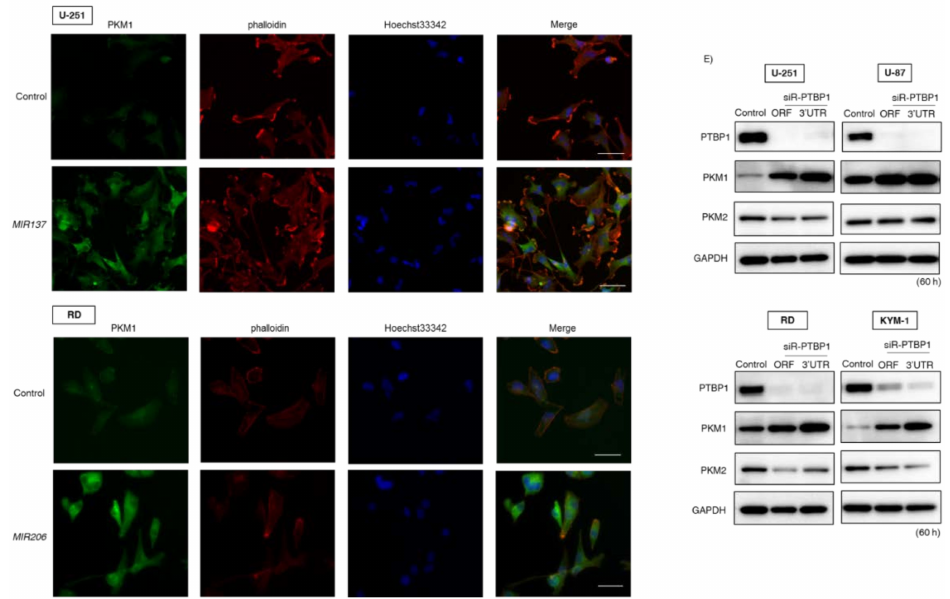
Figure 2. MIR137 and 206 regulated PKM isoform expression through the direct targeting of PTBP1 mRNA. ( A ) Protein expression levels of PTBP1 , PKM1 , and PKM2 at 60 h after the transfection with MIR137 or 206 . Human glioblastoma (GBM) cell lines (U-251 and U-87) were transfected with brain-specific MIR137 (20 nM). Also, rhabdomyosarcoma (RMS) cell lines (RD and KYM-1) were transfected with muscle-specific MIR206 (20 nM); ( B ) Luciferase activities after co-transfection with control or MIR137 or 206 and wild-type or mutant-type pMIR vectors having the predicted MIR137 or 206 binding site in the 3 (cid:48) UTR of PTBP1 . The upper panel shows the region of the 3 (cid:48) UTR of human PTBP1 mRNA complementary to the mature MIR137 or 206 . The box indicates the predicted binding sites for MIR137 or 206 . The left panel is the case of MIR137 transfected with U-251 cells. The right panel is the case of MIR206 transfected with RD cells. Effects were assessed at 24 h after the transfection (20 nM); ( C ) Protein expression levels of PTBP1 in U-251 and RD cells after combined treatment with antago MIR137 / MIR137 or antago MIR206 / MIR206 . Control lane: treatment with control miRNA (20 nM). MIR137 or 206 lane: treatment with MIR137 or 206 (20 nM). Inhibitor lane: treatment with MIR137 or 206 (10 nM) + antago MIR137 or 206 (10 nM). Effects were assessed at 60 h after the transfection; ( D ) Immunofluorescence of PKM1 at 60 h after transfection of U-251 cells with MIR137 or transfection of RD cells with MIR206 . Upper panels, treatment with control miRNA (20 nM); Lower panels, treatment with MIR137 or 206 (20 nM). PKM1 is dyed green; cell membrane, red; and nuclei, blue. Representative photographs from two experiments are shown. Scale bar = 50 µ m; ( E ) Protein expression levels of the PKM isoform in GBM and RMS cells at 60 h after siR- PTBP1 transfection (5 nM). ORF: open reading frame. Results are presented as the mean ± SD; * p < 0.05, *** p < 0.001; N.S., not statistically